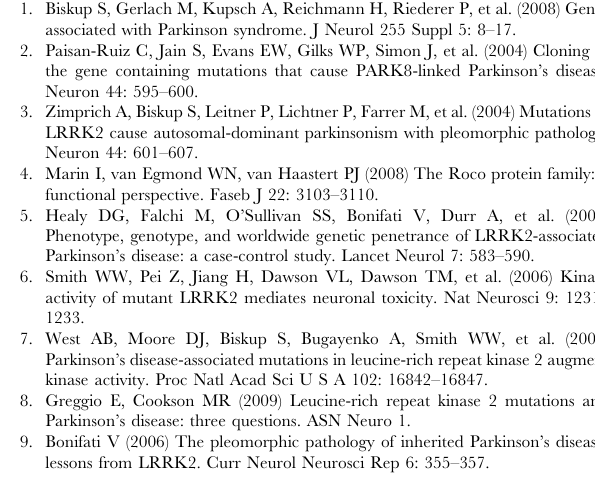
Figure S1 Effect of LRRK2 inhibitor GSK2578215A on DOPAC + HVA concentrations. PC12-derived cell lines were left untreated (A) or treated (B) with 1 m M of GSK2578215A. After 60 minutes of stabilization, three baseline dialysates were collected at 20-minute intervals as previously described. Starting from 60 minutes, nicotine was infused for 60 minutes. Micro- dialysates were continuously recovered during drug infusion and after nicotine discontinuation. Values are mean 6 SEM and refer to DOPAC + HVA concentrations in dialysates. Statistical signif- icance was assessed using analysis of variance (ANOVA) for differences over time determined by Newman-Keules t test and unpaired t -tests. * p , 0.05 compared with pertinent baseline values of all groups before nicotine treatment. Graphs in panel (C) and (D) represent the area under curve (AUC) values. (C) Basal DOPAC + HVA concentrations in dialysates of PC12 cell lines untreated or treated with 1 m M of GSK2578215A (minutes 20– 40–60 before nicotine treatment of Figure S1A vs B). (D) DOPAC + HVA in dialysates integrated after nicotine administra- tion in PC12 cell lines untreated or treated with 1 m M of GSK2578215A (from minutes 80 to 220 after nicotine treatment of Figure S1A vs B). AUC values are mean 6